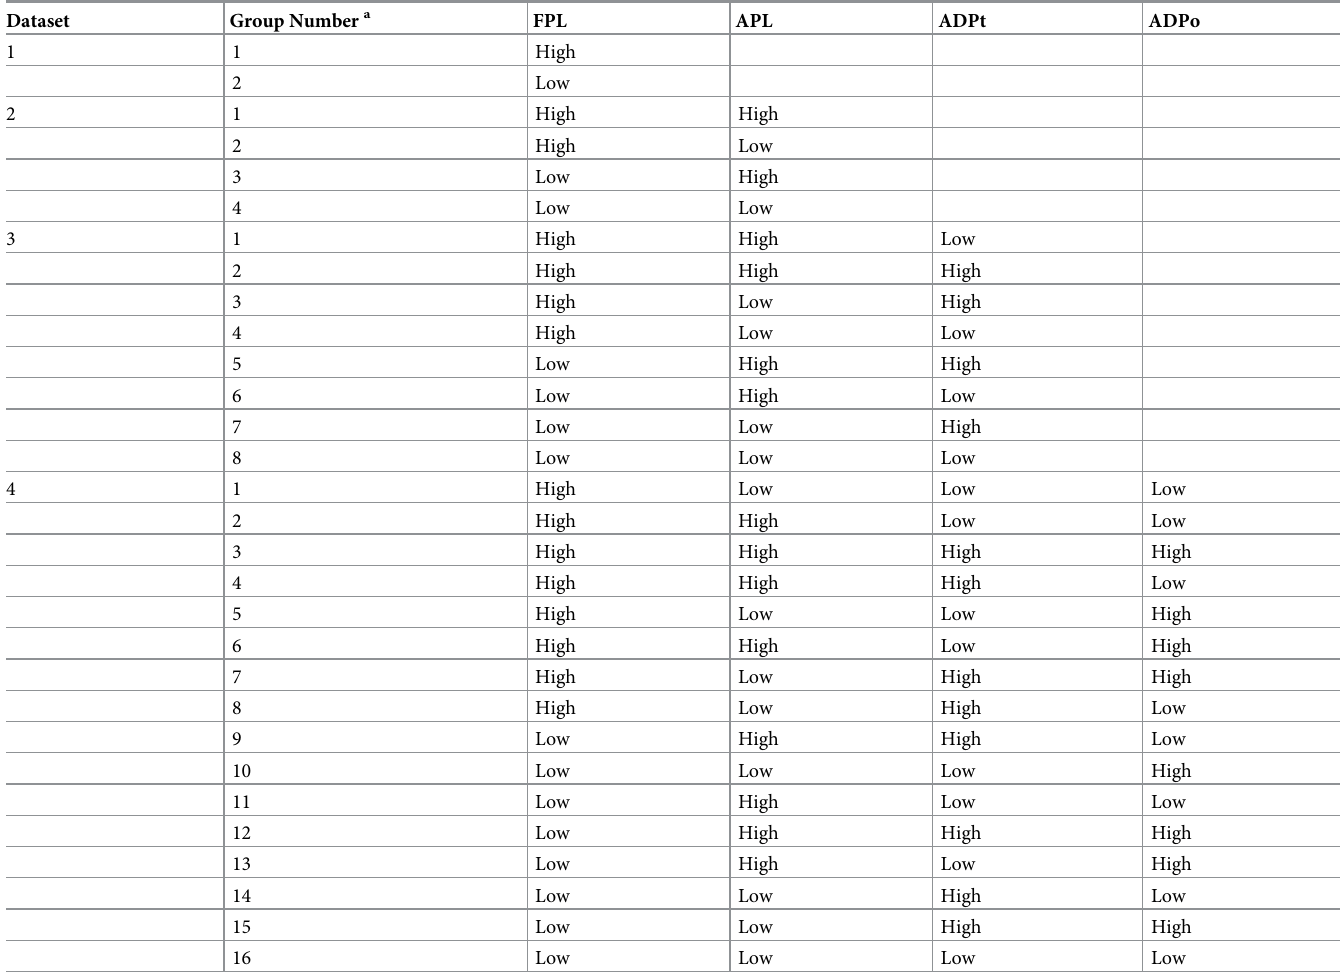
Table 4. Maximum isometric force (above or below the mean) associated with labeled groups of each dataset.